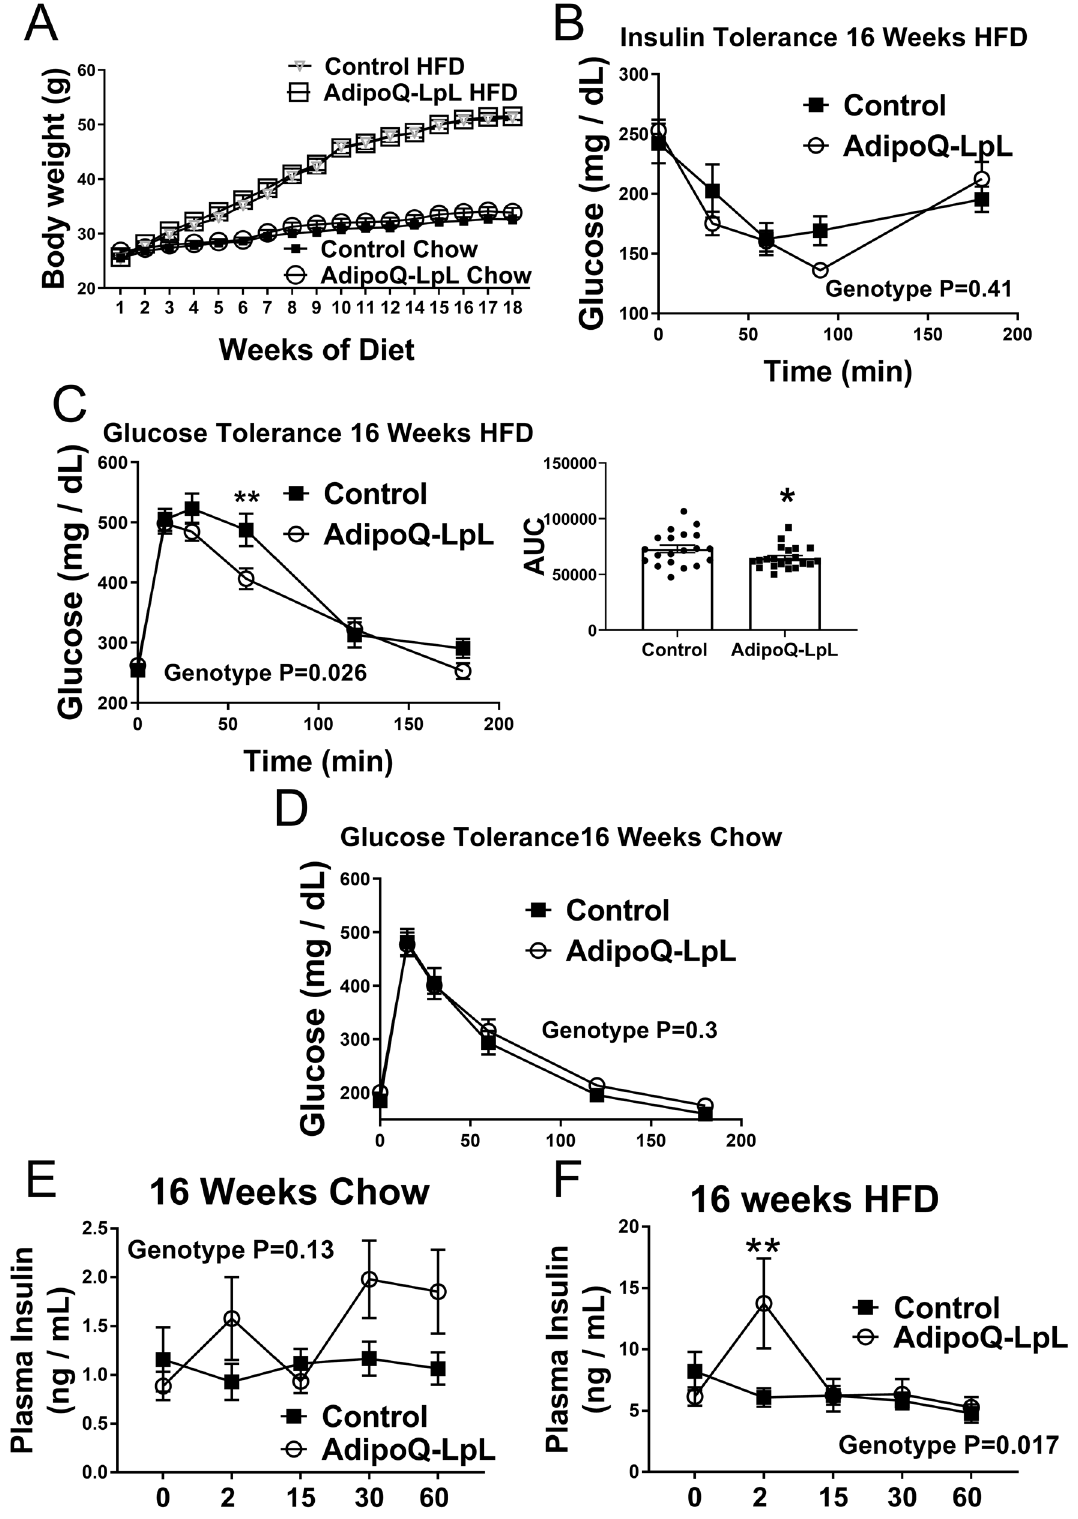
Figure 8. Glucose homeostasis and insulin secretion of control and AdipoQ-LpL mice. ( A ) Weight of the mice after switching to HFD (control n = 20; AdipoQ-LpL n = 21) or maintaining on chow (n = 12) starting at 8-weeks. ( B ) Glucose tolerance of control and AdipoQ-LPL mice after 16 weeks of HFD (control n = 20; AdipoQ-LpL n = 21). ( C ) Insulin tolerance of control and AdipoQ-LPL mice after 16 weeks of HFD (control n = 9; AdipoQ- LpL n = 9). Inset: analysis of area under the curve. ( E , F ) Plasma insulin levels after glucose injection of control and AdipoQ-LPL mice after chow or HFD for 16 weeks (control n = 11; AdipoQ-LPL n = 12; both cohorts 2 min glucose n = 6). Data were analyzed by RM 2 way ANOVA **P < 0.01; interaction P values for genotype are indicated in the